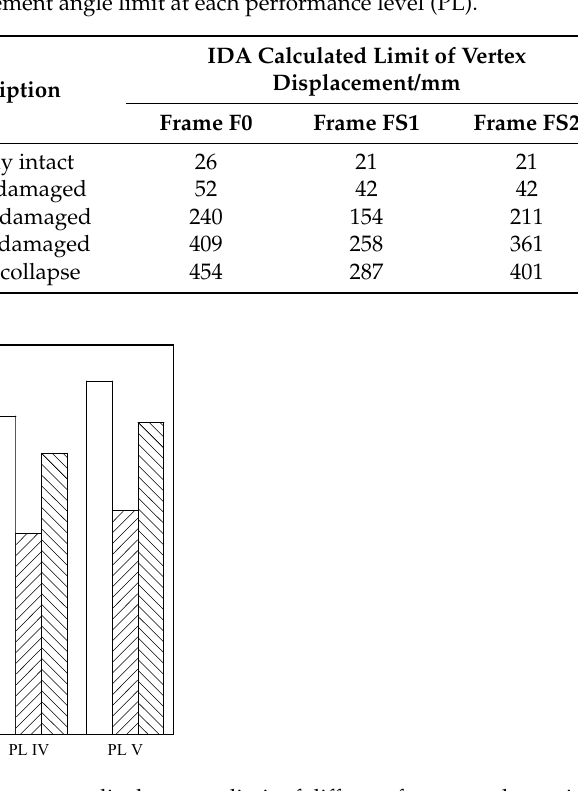
Figure 18. Comparison of the maximum vertex displacement limit of different frames under various performance levels.